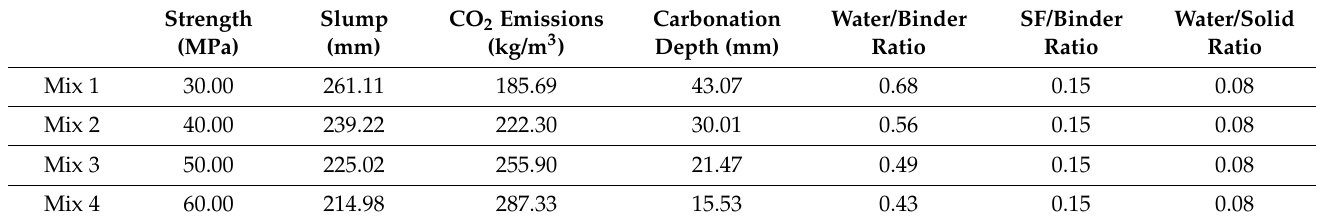
Table 7. Performance of optimal design mixtures for Case 1: low-CO 2 concrete without